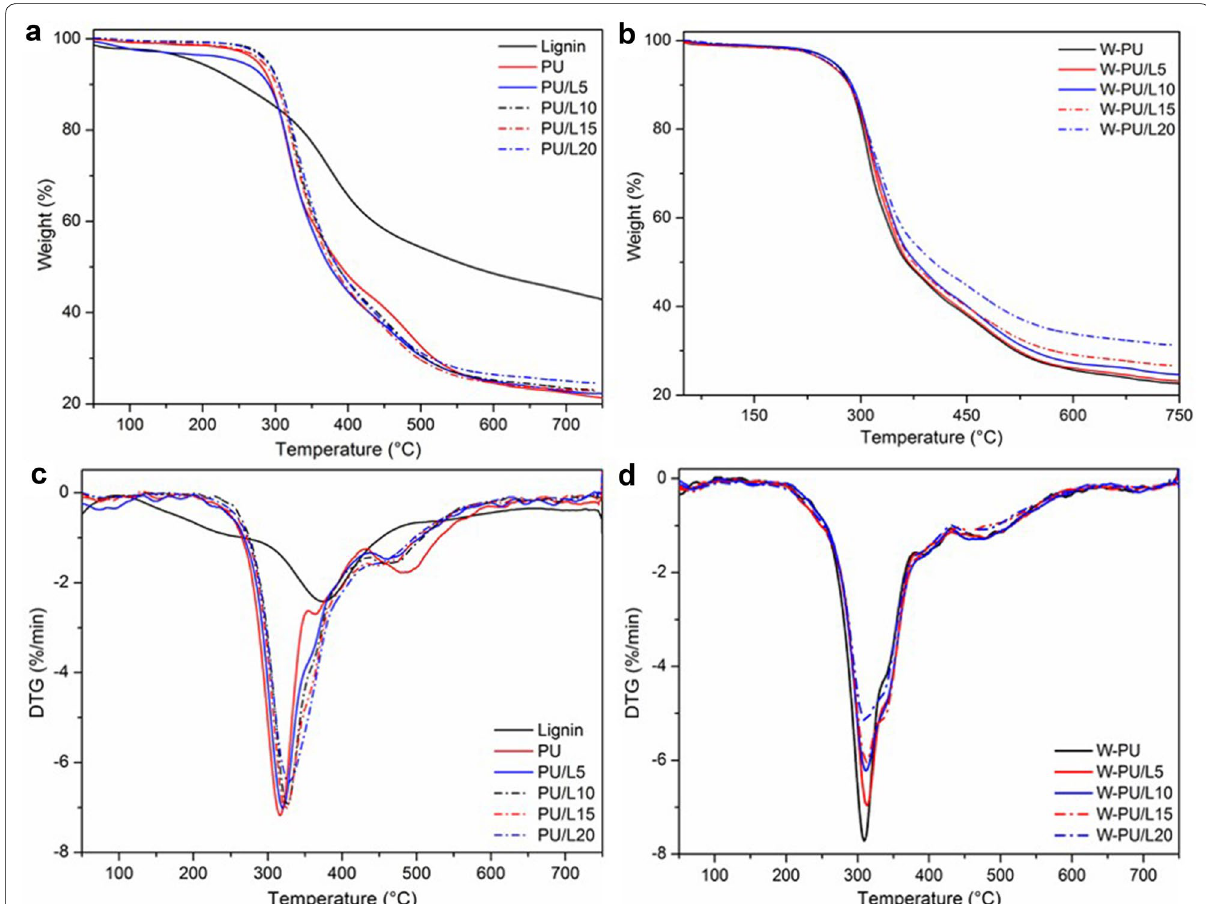
Fig. 8 a , b TG and c , d DTG curves of the PU and W–PU foams with varying lignin